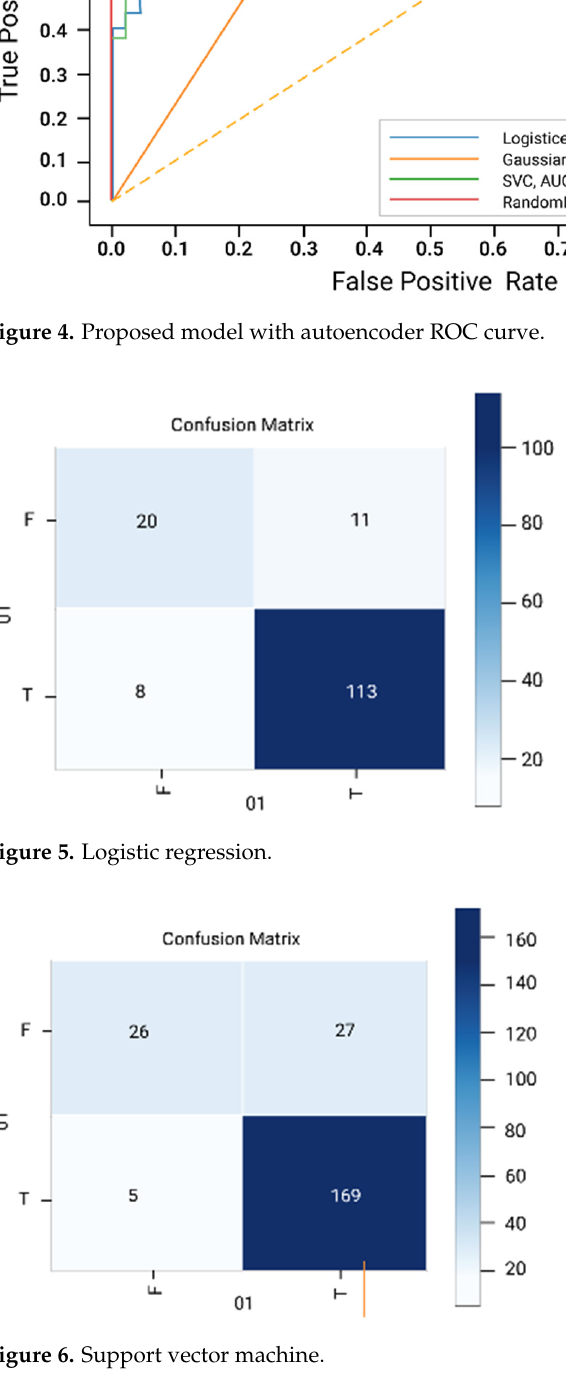
Figure 6. Support vector machine.